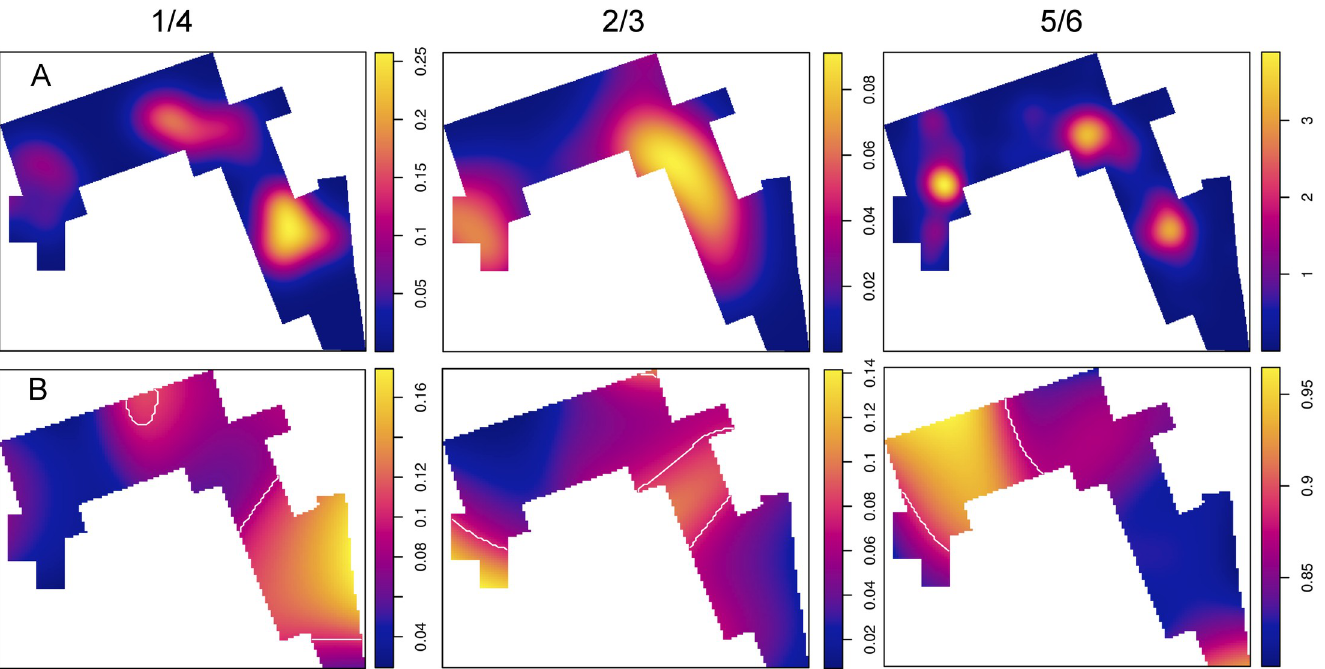
Fig 16. Flake types. A. Density maps of the spatial distribution of flakes according to Toth’s types [110]. B. Spatial probability distribution of flake types Tolerance contours (white) show areas of significant deviation from the average proportion.